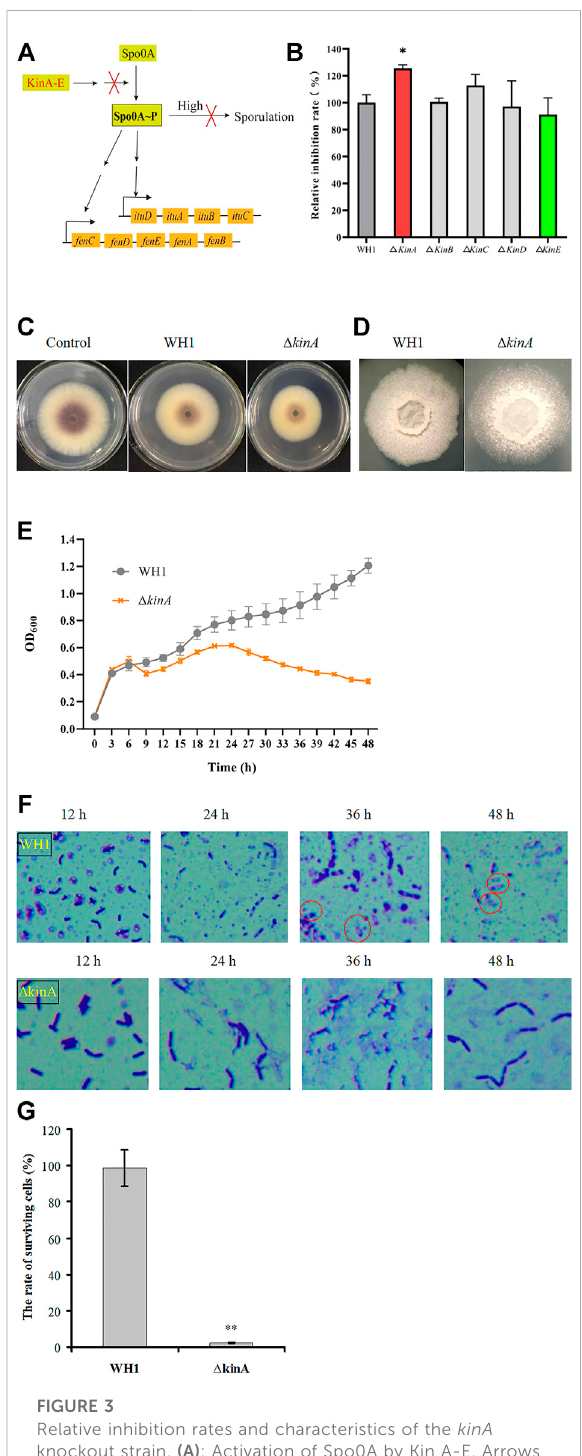
FIGURE 3 Relative inhibition rates and characteristics of the kinA knockout strain. (A) : Activation of Spo0A by Kin A-E. Arrows mean the promotion role; T-bars men the inhibition role; “ High ” means the high level of Spo0A~P. (B) : Relative inhibition rates. (C) : Antifungal activity determined on